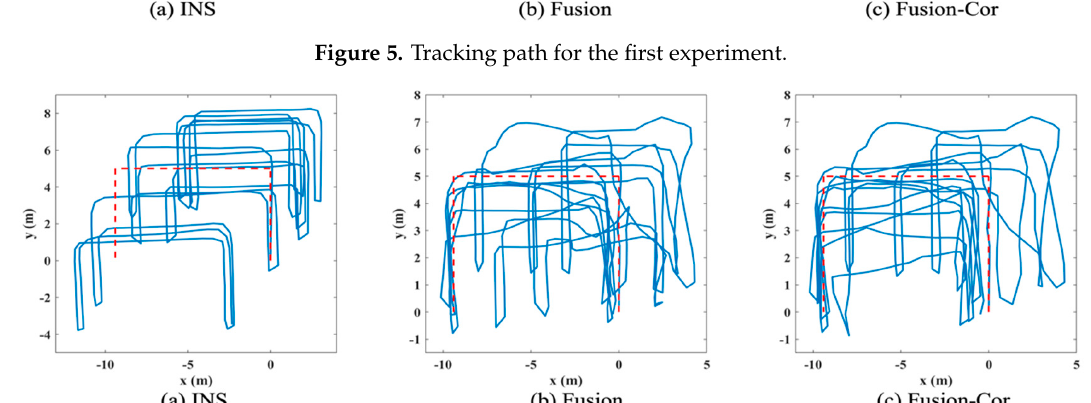
Figure 6. Tracking path for the second experiment.